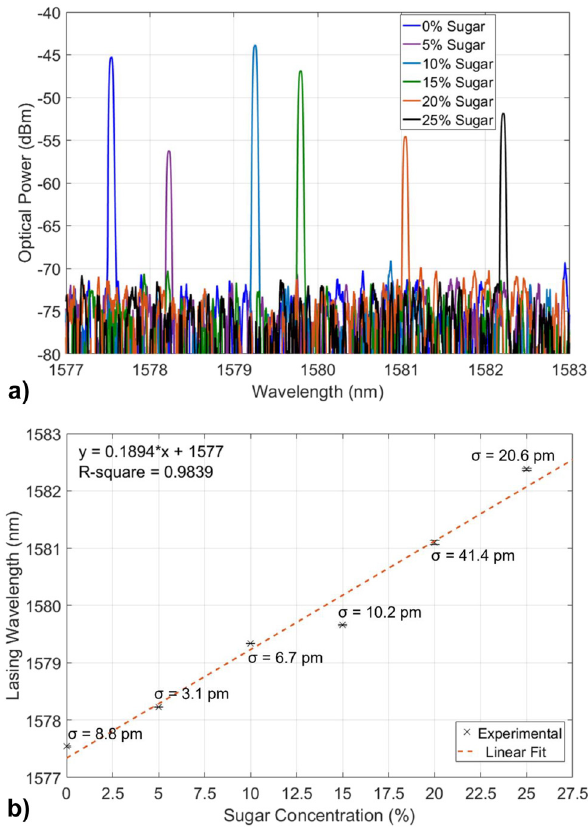
Figure 11: HECL wavelength shift with solutions, (a) Experimental lasing spectra of the HECL based RI sensor in solutions of DI water and increasing concentrations of sugar (C and (b) experimental lasing wavelength shift with increasing sugar concentration with error bars and standard deviation, fitted linearly (red dashed